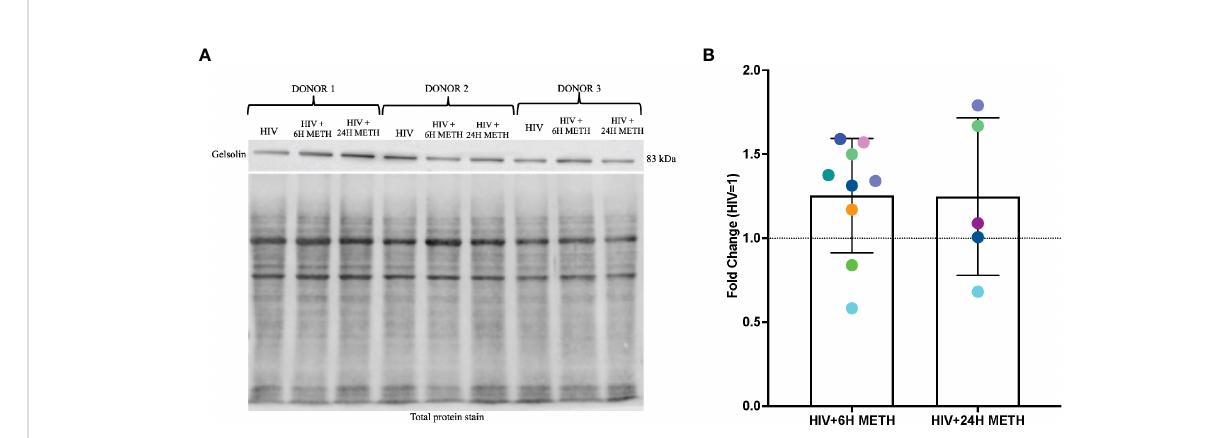
FIGURE 5 Gelsolin protein is increased in HIV-infected mature monocytes treated with meth. (A) A representative gelsolin western blot with corresponding total protein stain of HIV-infected mature monocytes either untreated or treated for 6 h or 24 with meth. (B) Fold change of